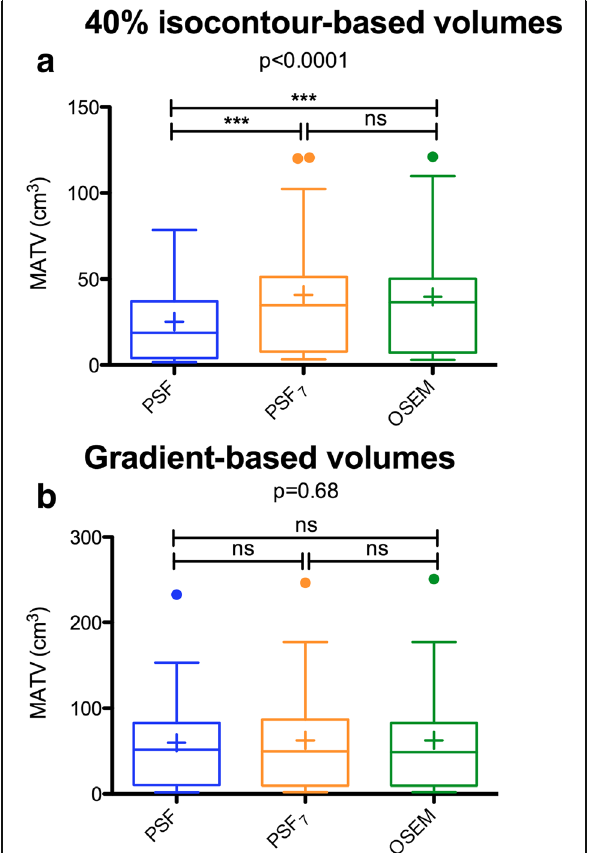
Fig. 3 Impact of the EARL harmonization strategy on MATVs defined by the isocontour and gradient-based delineation methods (observer 1). MATVs are shown as Tukey boxplots ( lines displaying the median, 25th, and 75th percentiles; cross represents the mean values). Legends for p values: ***<0.001; **<0.01; *<0.05. ns non significant. a 40% isocontour-based volumes. b Gradient-based